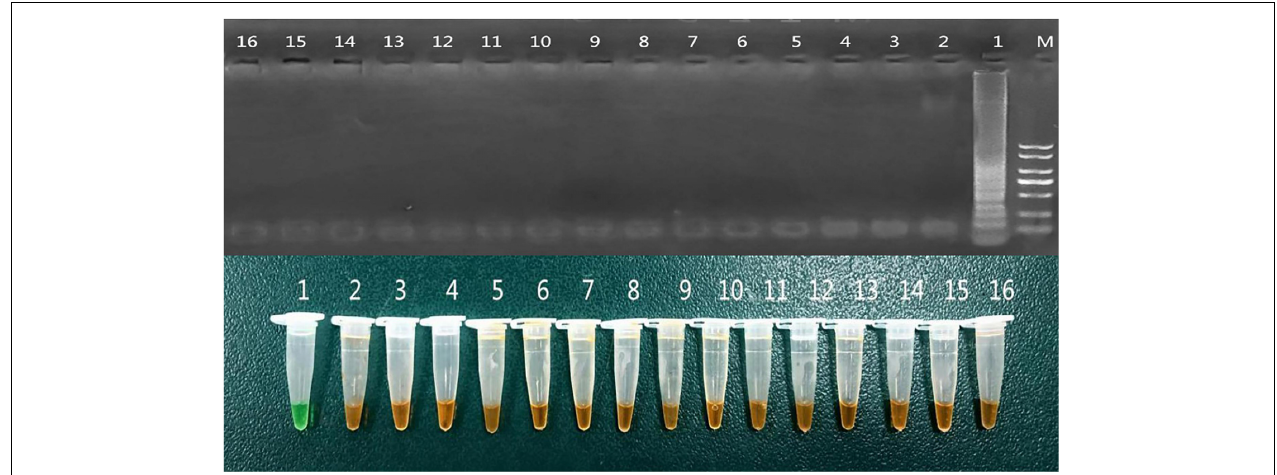
and B3) as described previously (Liao et al., 2019). The PCR